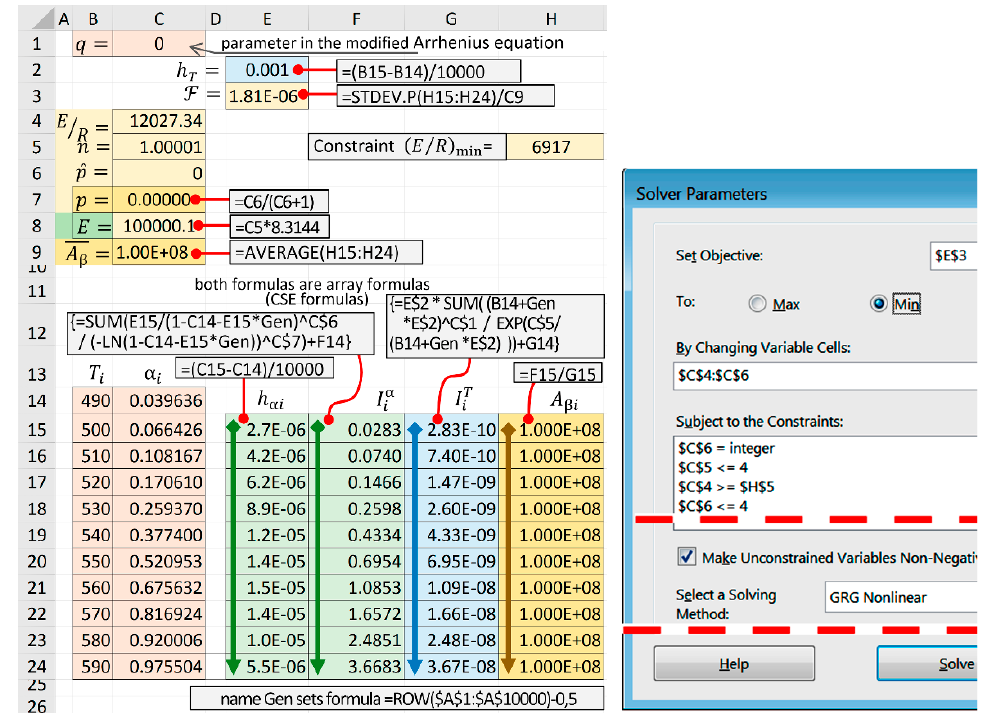
Figure 2. MS Excel worksheet screenshot (after executed the Solver add-in) and the Solver Parame- ters panel.